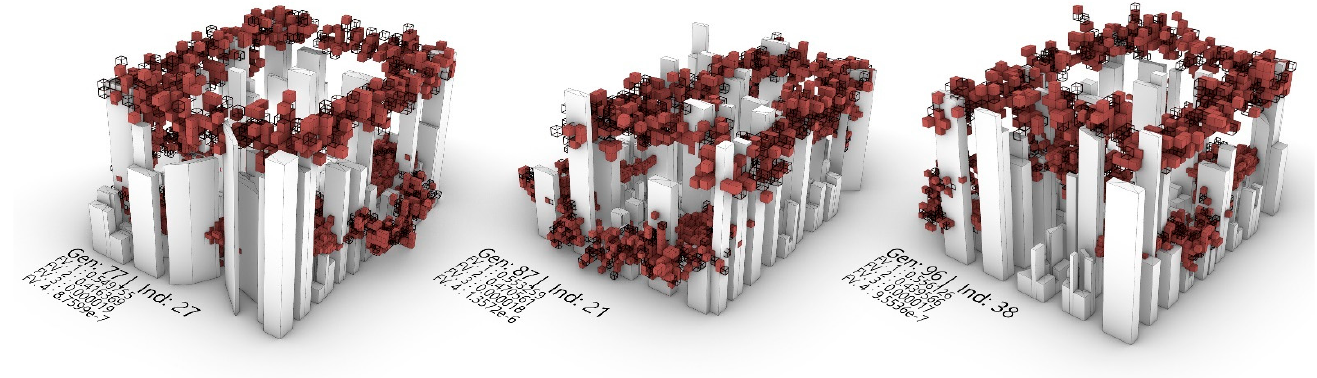
Figure 21. The phenotypes of the selected three solutions from Figure 20.